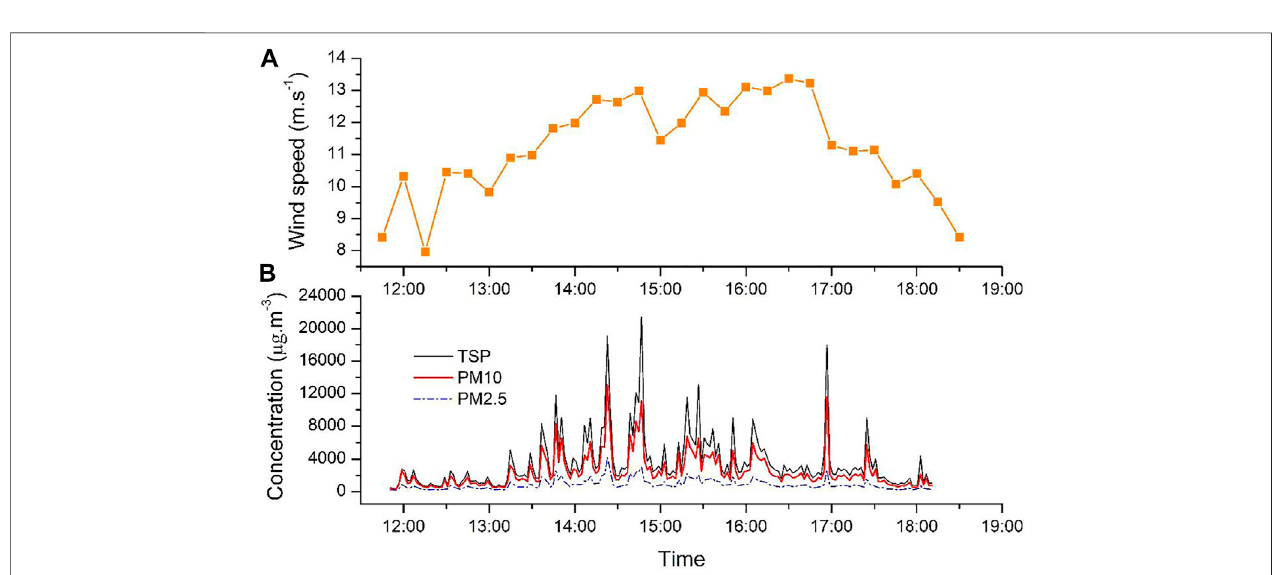
FIGURE6| Windspeedsat theheightof2 matoptheMogaoGrottoes (A) andthecorrespondingdust concentrations (B) changingwithtimeunder atypical dust storm of westerly winds on 1 April 2012.